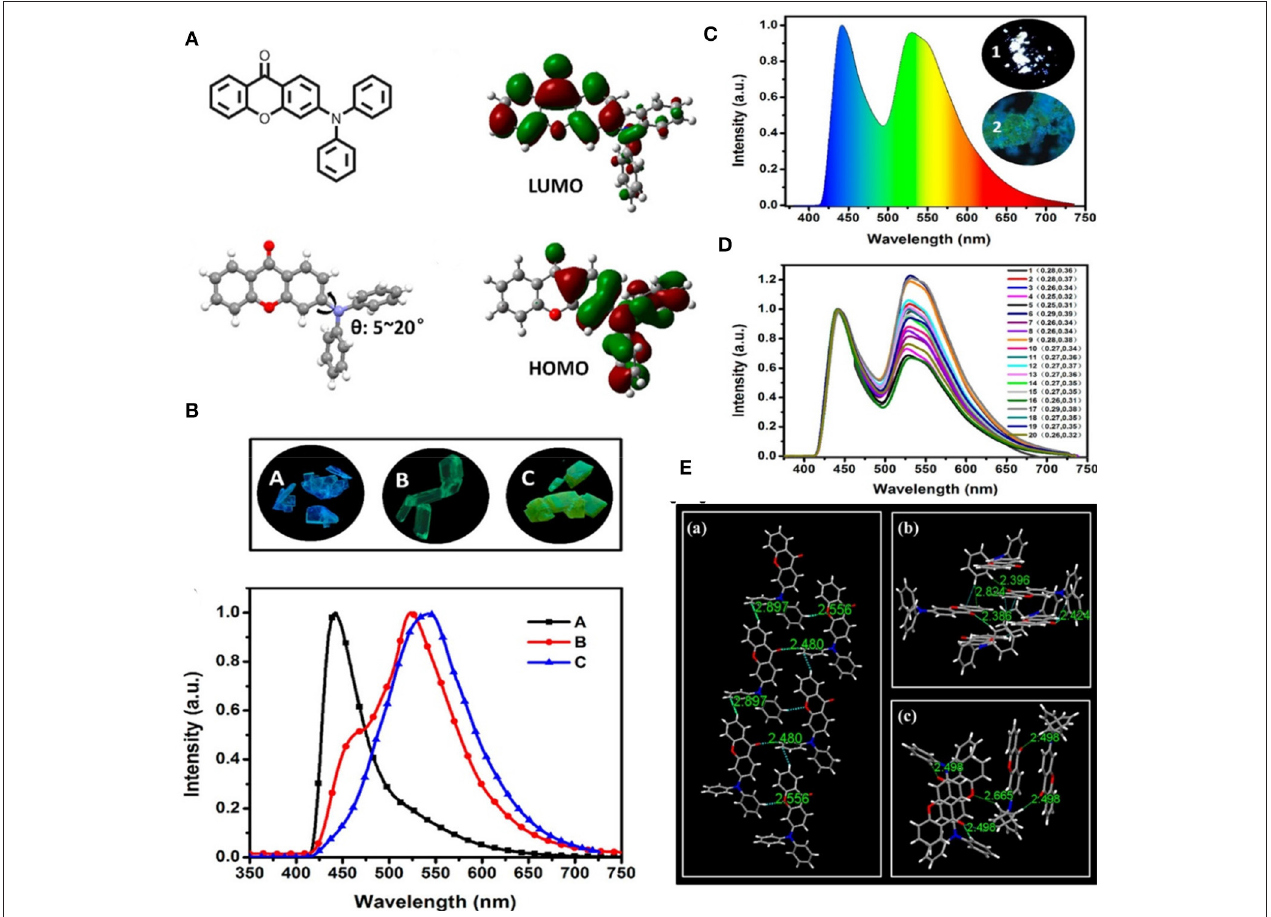
FIGURE 17 | (A) Chemical structure of 3-DPH-XO (left side-top) followed by single crystal structure (left side-bottom) and theoretical spatial HOMO-LUMO distribution. (B) Photographs of the polymorphs with normalized fluorescence spectra (bottom) recorded under 365nm UV excitation. (C) Result of 20 combined emission spectra of powdered-3-DPH-XO under 365nm UV irradiation; inset: (1 and 2) fluorescence microscopy image of the powder. (D) Respective color-coordinates (CIE 1931) of 20 random emission spectra of solid- 3-DPH-XO under 365nm UV excitation. (E) Intermolecular interactions and overlaps in A (a), B (b), and C (c) crystals. Reproduced with permission from Zhang et al. (2017). Copyright © American Chemical